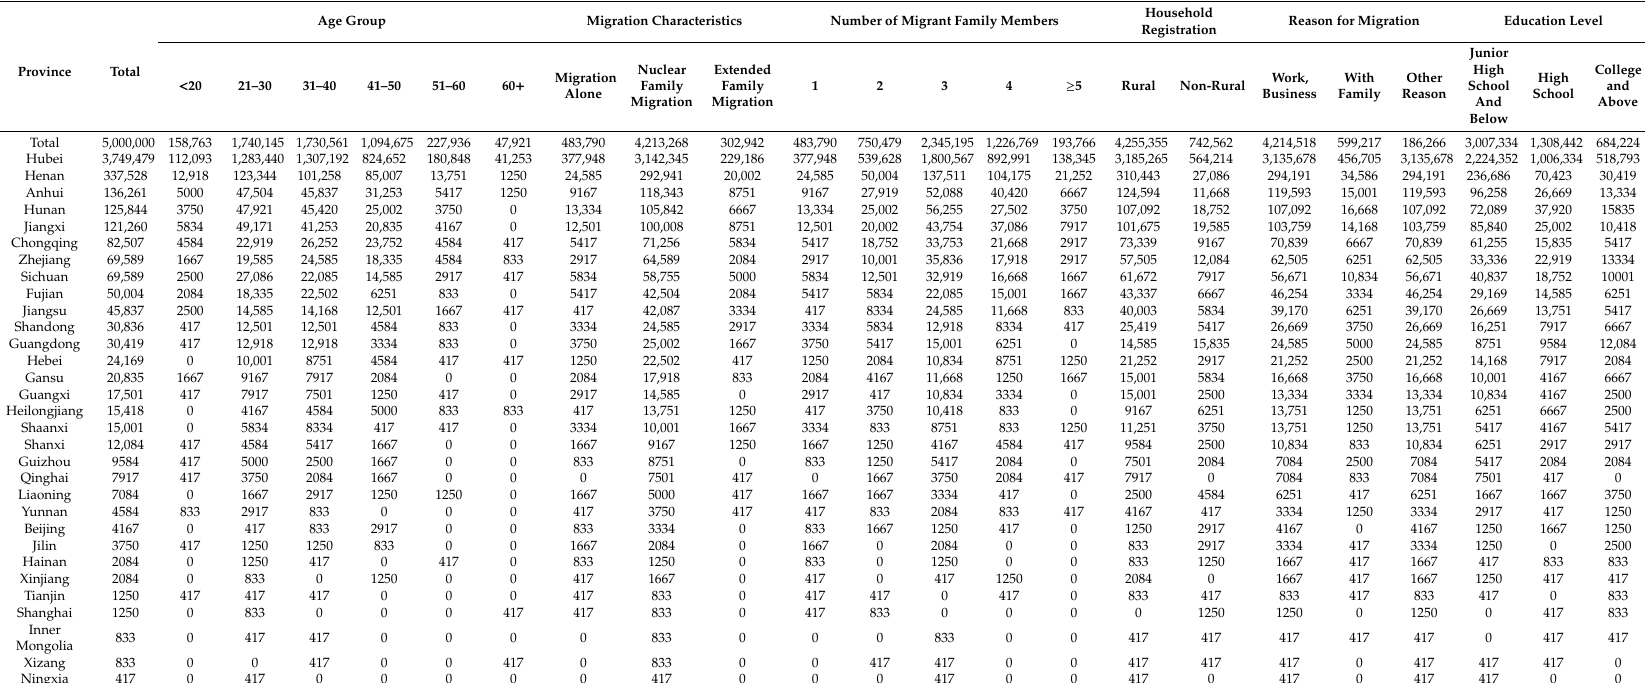
Table 5. Joint distribution of Wuhan floating population in